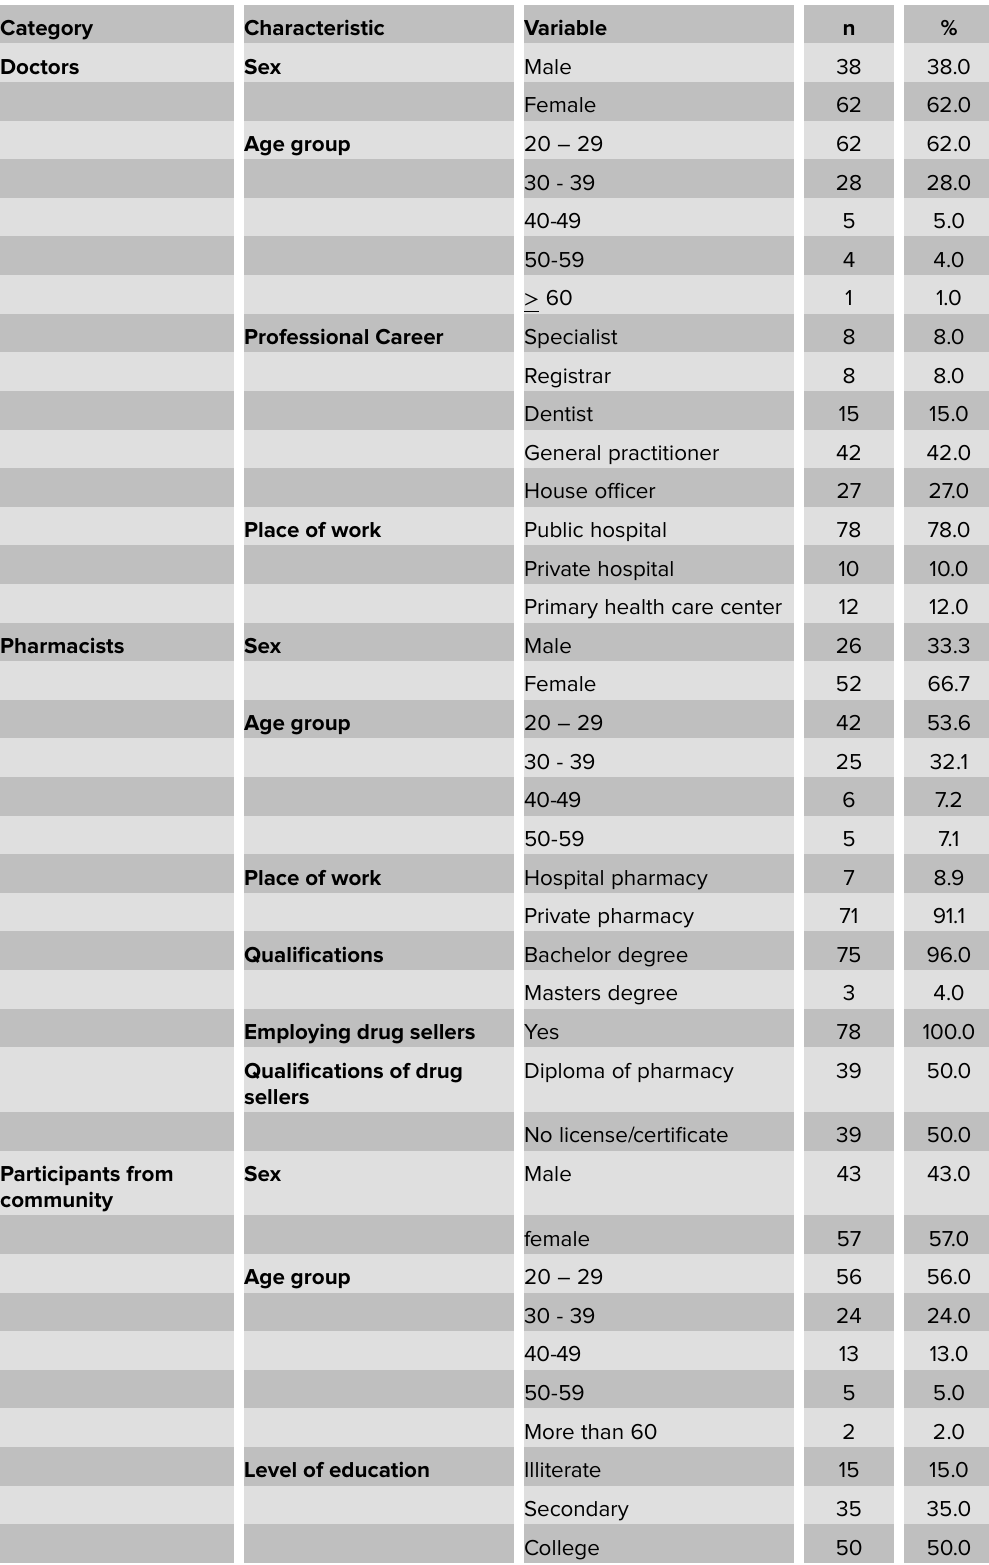
Table 1: The socio-demographic characteristics of study population. River Nile State, Sudan 2014 (n=278).